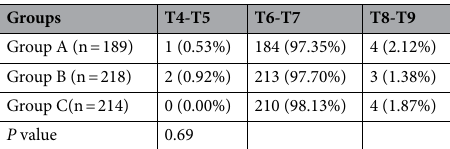
Table 3. The distribution of catheter tip localization in the three groups [n